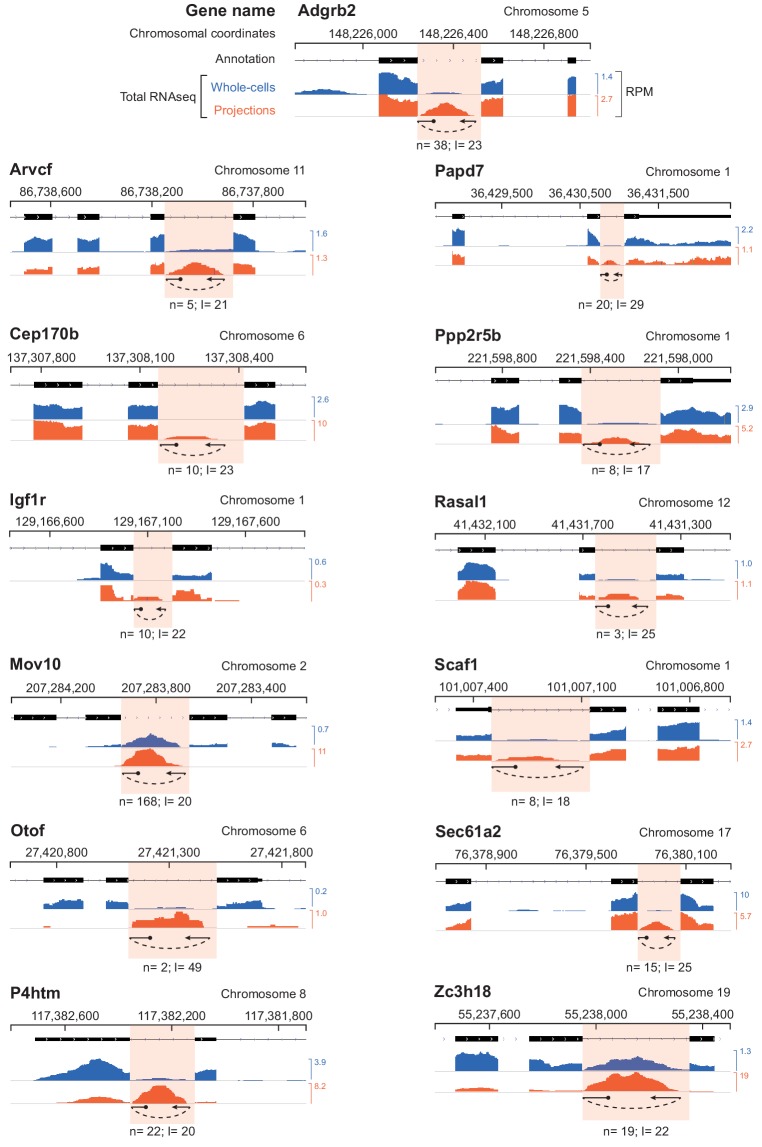
Genome browser plots of projection-localized free introns with circularly permuted reads.Genome browser plots of projection-localized free introns with circularly permuted reads are shown. The total number of circularly permuted reads, ‘n’, in projection libraries as well as the distance of the branchpoint from the 3’ splice site, ‘l’ are shown below each intron. RPM = Reads per million mapped. More details about circularly permuted read alignments are provided in Figure 6—source data 1.